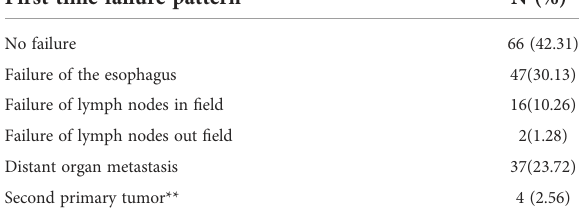
TABLE 2 First failure